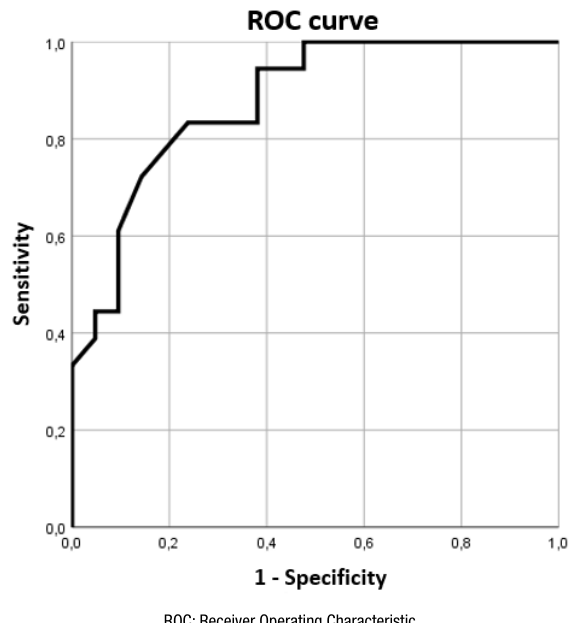
Figure 2. Receiver Operating Characteristic curve of predicted variability ROC: Receiver Operating Characteristic. (AUC=0.877).